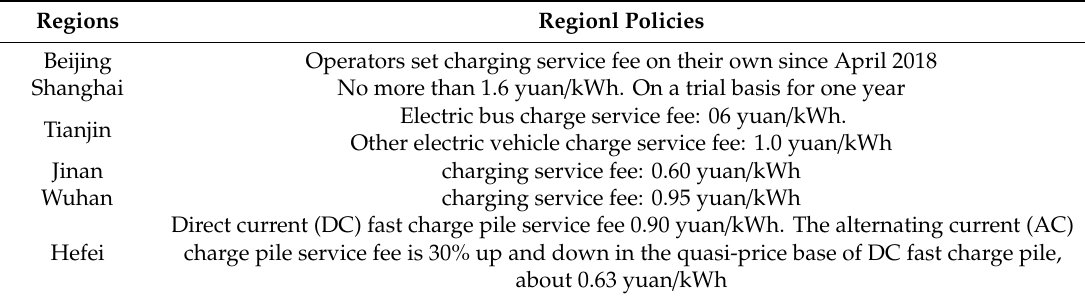
Table 2. Charging service fees in some regions in China